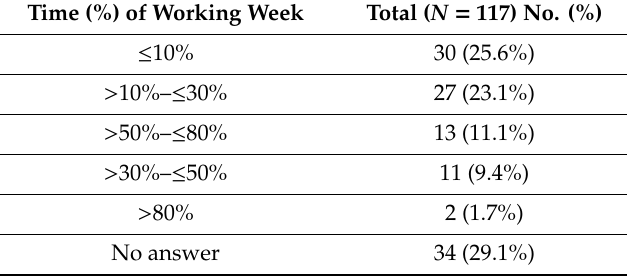
Table 2. Proportion of working week spent on treating children with chronic